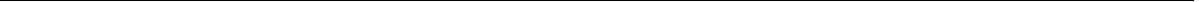
Fig. 3 B4GALT3 is a direct downstream target of miR-1247-3p in fi broblasts activation. a Target gene prediction of miR-1247-3p with two bioinformatics tools. b qRT-PCR and immunoblotting assays of B4GALT3 expression in MRC5 treated with miR-1247-3p mimic or normal control. c The wild-type and a mutated type of binding site between miR-1247-3p and B4GALT3. d Relative luciferase activity of MRC5 in the presence of indicated treatments. e , f Migration assay and qRT-PCR analysis of MRC5 transfected with siRNAs targeting B4GALT3 or control. Scale bar, 150 μ m. g MiR-1247-3p effect on migration ability of MRC5 in the presence of B4GALT3 or not. Migrated cells were counted and representative images were shown. Scale bar, 150 μ m. h qRT-PCR analysis of pro-in fl ammatory genes expression in MRC5 with indicated treatments. Experiments were performed at least in triplicate and results are shown as mean ± s.d. Student ’ s t -test was used to analyze the data (NS, not signi fi cant; * p < 0.05; ** p < 0.01; *** p <